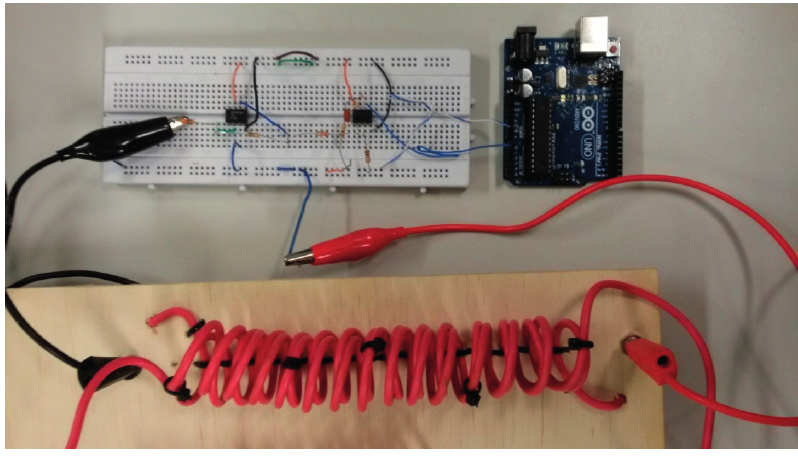
Figure 5. Prototype of the proposed sensor.